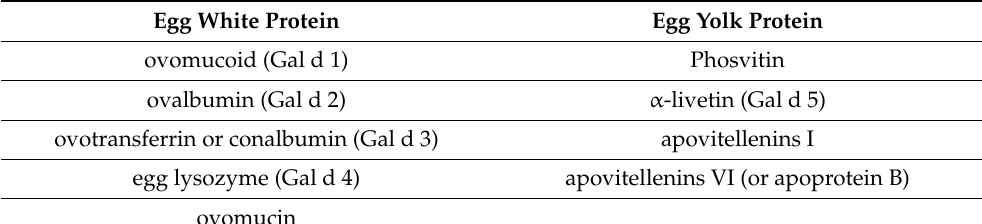
Table 2. Differences in allergenic proprieties between egg yolk and egg white